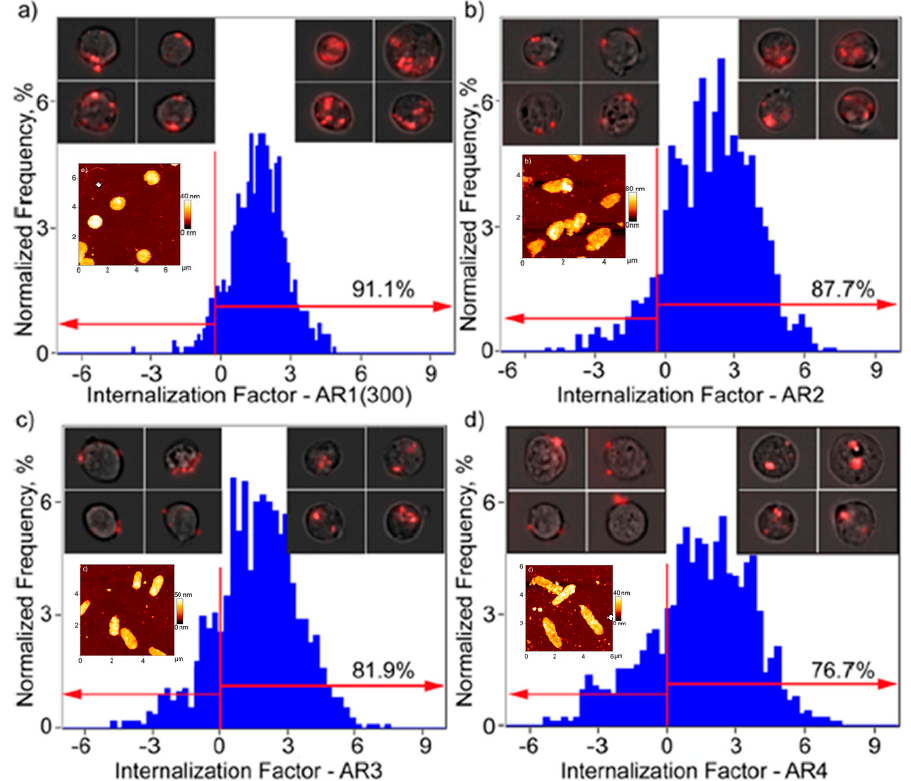
Figure 5. Quantification of the internalization of AF633-labeled PMAA HCs in HeLa cells by imaging flow cytometry. The cells were incubated with capsules at a capsule-to-cell ratio of 100:1 for 6 h at 37 ◦ C, 5% CO 2 . The degree of internalization is expressed as the internalization factor (IF). Each panel shows in the top corners insets an overlay of the bright-field and fluorescence images of cells for two representative areas: capsules bound with the cell membrane (negative IF) and capsules internalized within cells (positive IF). In addition, in each corresponding panel AFM images of PMAA HCs with various aspect ratios are reported. Adapted from Ref. [79].